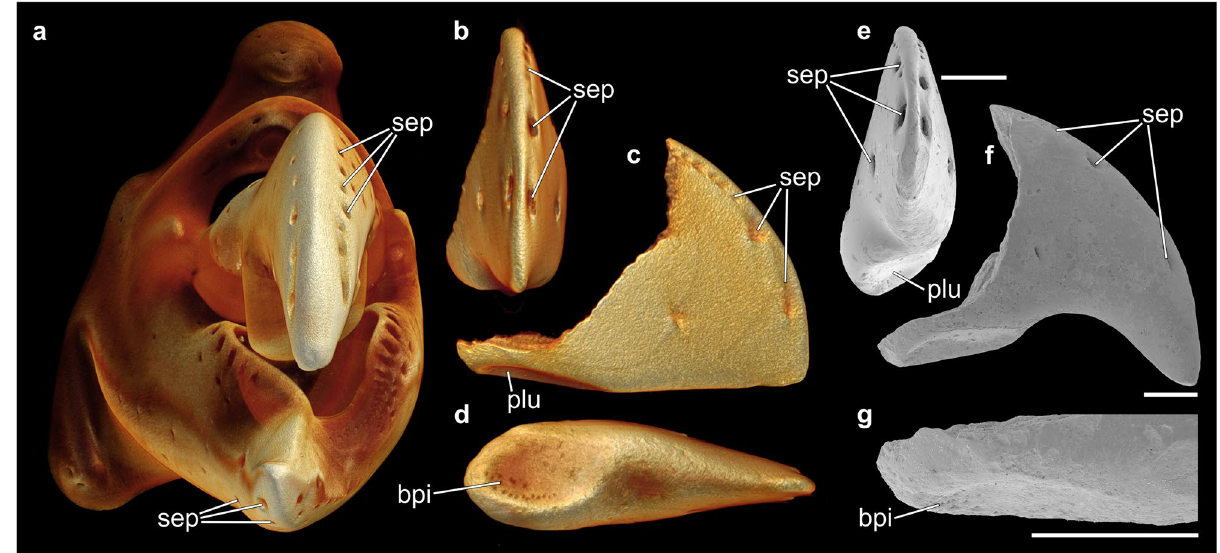
Figure 6. Pore arrangement in extant alpheid snapping claws and corresponding fossil samples. ( a ) Anterior view of a µ CT-based volume rendering of the snapping claw of Alpheus bisincisus , preserved specimen (NHMW-CR-25767). ( b – d ) µ CT-based volume renderings of a fossil dactylus fingertip (NHMW 2016/0154/0010). Anterior ( b ), inner ( c ), and occlusal ( d ) views. ( e , f ) SEM micrographs of a fossil dactylus fingertip (NHMW 2016/0154/0006). Anterior ( e ) and inner ( f ) views. ( g ) Close-up view of the basal pits located on the occlusal side of a fossil dactylus fingertip (NHMW 2016/0154/0004). bpi = basal pit, plu = plunger, sep = setal